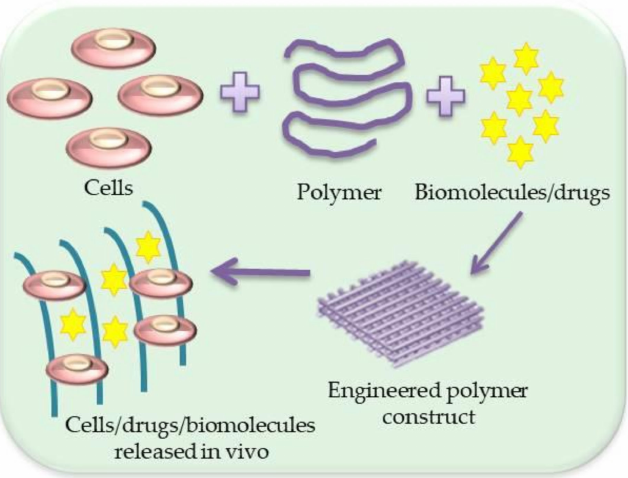
Figure 2. Schematic illustration of scaffold with cells/drugs or biomolecules’ formation.